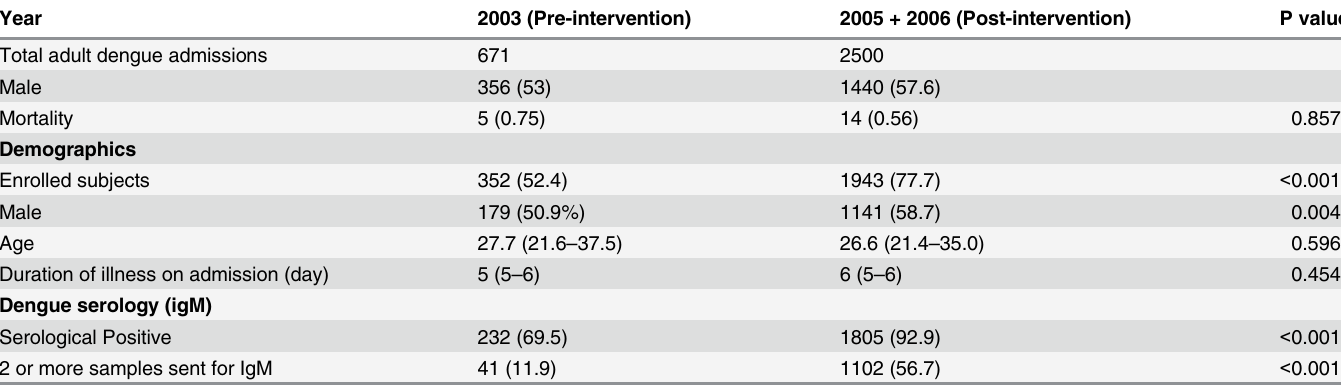
Table 1. Summary of results: Demographics and dengue IgM serology